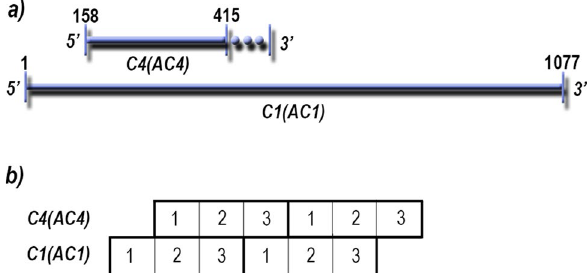
Figure 1. C4(AC4) overprinted on C1(AC1). ( a ) C4(AC4) gene overprinted on the C1(AC1) gene. Nucleotide positions refer to nucleotide positions of isolate AF379637 (Beet curly top virus, BCTV-CA/Logan[US:Log:76]) where the BCTV C4 gene encodes for a protein of 85 amino acids. The region following nucleotide position 415 indicates that some geminiviruses have C4(AC4) genes that encode for proteins that have lengths greater than 85 amino acids. ( b ) Schematic showing + 1 frameshift of C4(AC4) relative to the C1(AC1)